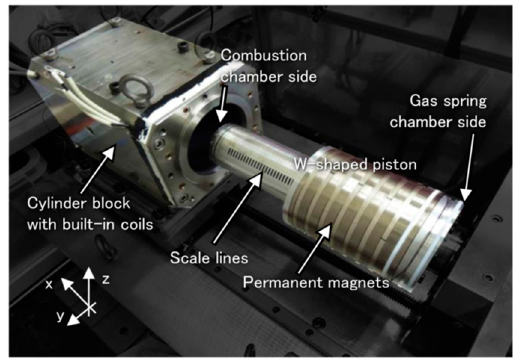
Figure 6. Linear generator structure of the first prototype of Toyota Central R&D [14].